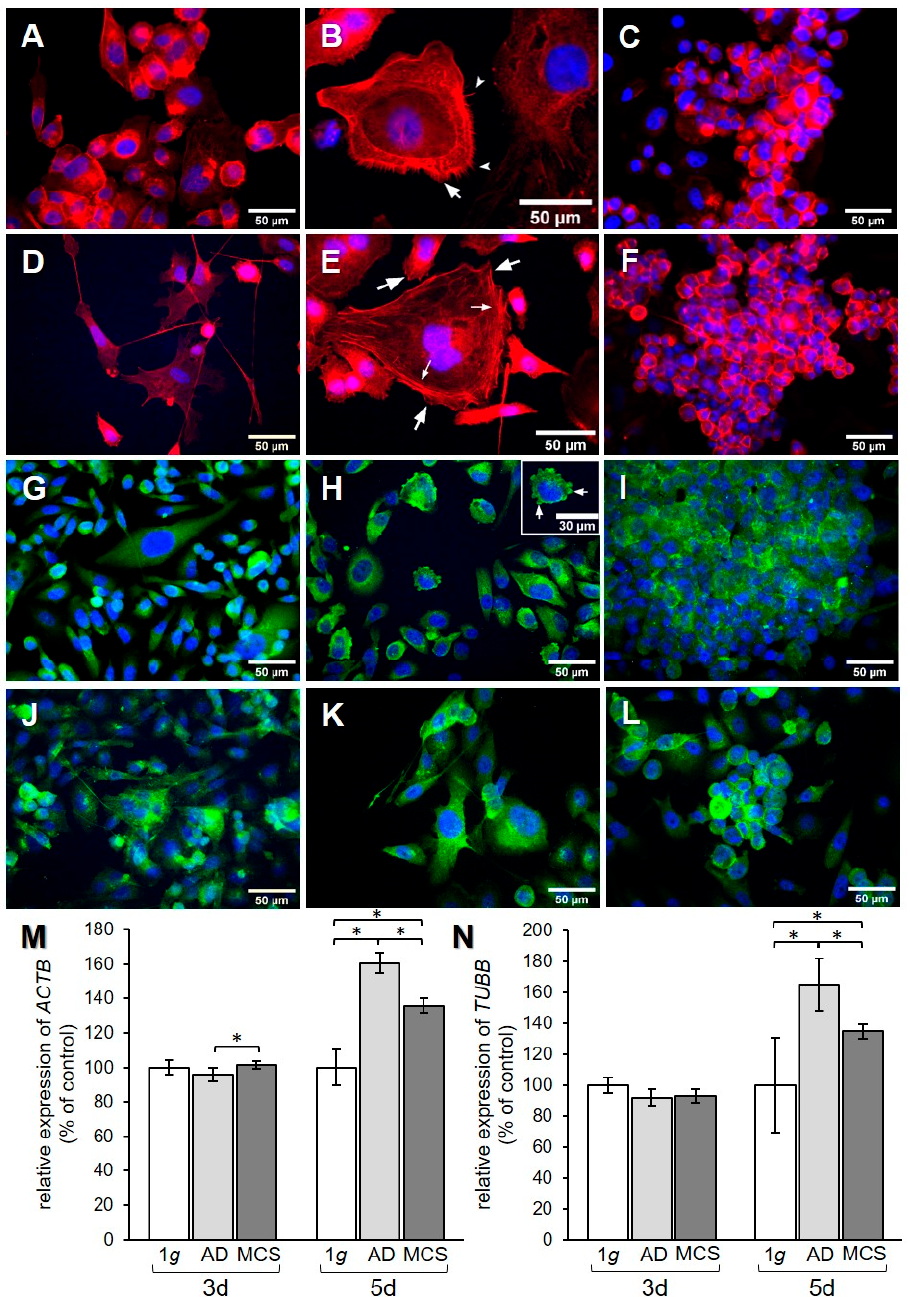
Figure 3. Investigation of the cytoskeleton. F-actin visualized by means of phalloidin and immunofluorescence (IF) staining for β -actin. F-actin pictures show ( A ) 3-day 1 g control, ( B ) 3-day AD, ( C ) 3-day MCS, ( D ) 5-day 1 g, ( E ) 5-day AD, and ( F ) 5-day MCS. Big arrows in ( B ) and ( E ) point to lamellipodia, notched arrows in ( B ) point to filopodia, and small arrows in ( E ) point to stress fibers. β -actin pictures show ( G ) 3-day 1 g control, ( H ) 3-day AD, ( I ) 3-day MCS, ( J ) 5-day 1 g, ( K ) 5-day AD, and ( L ) 5-day MCS. Arrows in ( H ) point to membrane blebbing. Relative mRNA transcription levels of ( M ) ACTB and ( N ) TUBB genes in 3-day and 5-day samples were analyzed by qPCR. * p < 0.05.